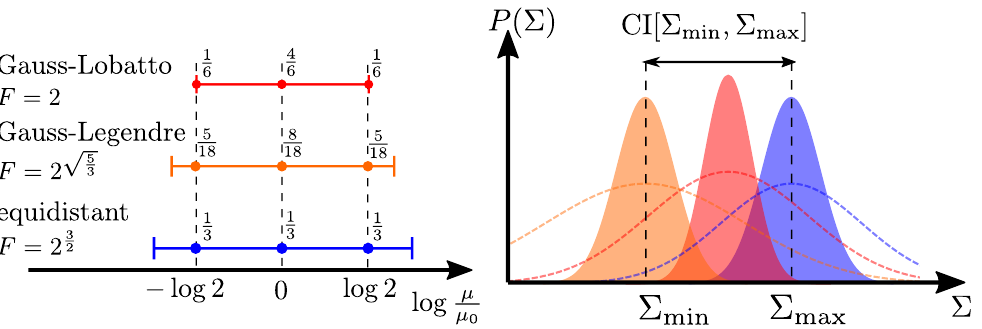
Figure 1 . Left: the integration regions for different quadrature rules using scale variation points. Right: sketch of probability distributions at scale variation points when the width is smaller than scale variation interval (shaded) and when it is larger (dashed